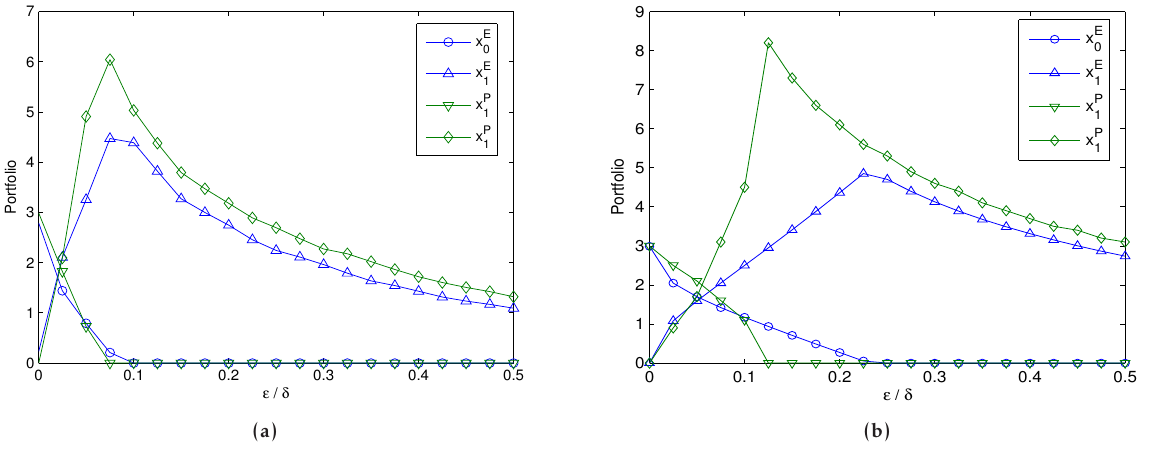
Figure 3. Primary ( x E , x P ) and secondary ( x E , x P ) contract units in the SPO when demand and bandwidth distributions are modeled 0 0 1 1 as beta distributions. a) Demand and secondary bandwidth return are independent, b) Demand and bandwidth return are correlated with degree of correlation being